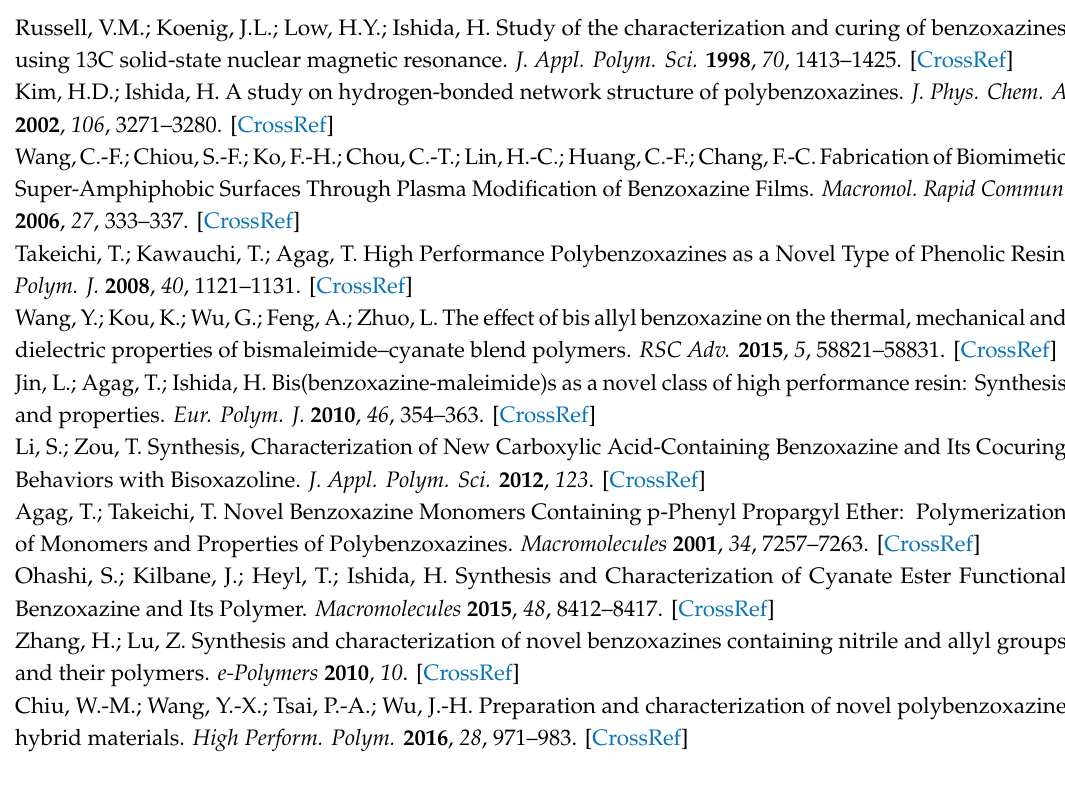
Figure S1. 31 P NMR spectrum of phosphazene-containing benzoxazines at HCF: bisphenol A ratios of 1:24 (spectra at ratios of 1:12, 1:16, 1:24 are identical). Figure S2. 1 H NMR spectrum of the phosphazene-containing benzoxazine obtained at a ratio of HCF: bisphenol A = 1:24. Figure S3. 1H NMR spectrum of the phosphazene-containing benzoxazine obtained at a ratio of HCF: bisphenol A = 1:16. Figure S4. 1H NMR spectrum of the phosphazene-containing benzoxazine obtained at a ratio of HCF: bisphenol A = 1:12. Figure S5. ESI + mass spectra of phosphazene-containing benzoxazine. Retention time: A—13.7 min, B—15.1 min, C—16.4 min, D—17.8 min. Figure S6. TGA curves of BA-a and phosphazene-containing benzoxazines based polymers obtained in air (a) and in argon (b). Table S1. Determining the flammability class of samples according to UL-94 standard. Figures S7–10— 1 H NMR spectra of BA-a and phosphazene-containing benzoxazine obtained at a ratios of HCF: bisphenol A of 1:24, 1:16 and 1:12